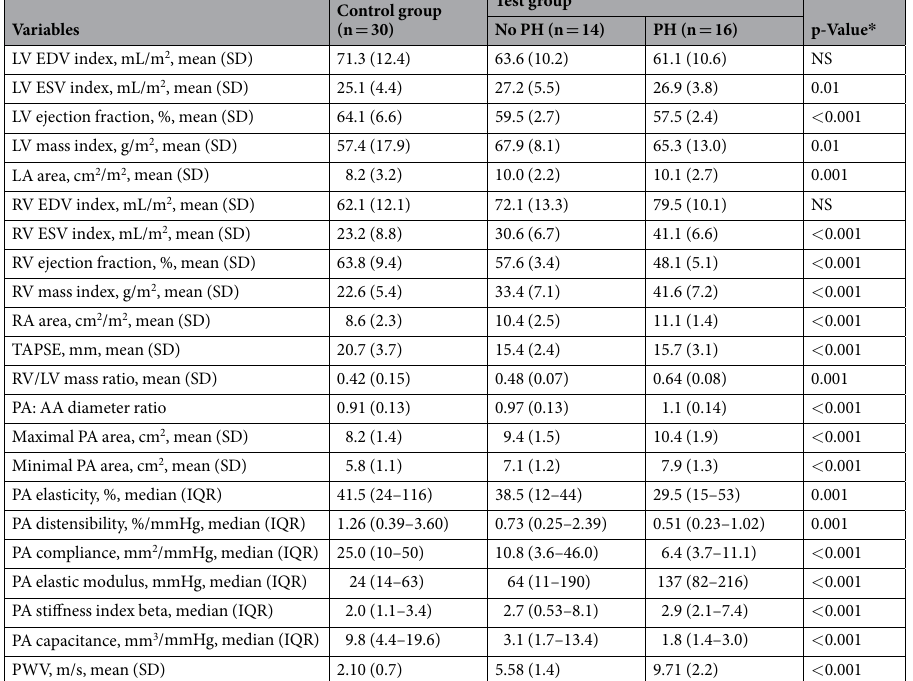
Table 2. CMR imaging characteristics in the study population. Abbreviations: AA, ascending aorta; LA, left atrium; LV, left ventricle; LVEDV, left ventricular end-diastolic volume; LVESV, left ventricular end-systolic volume; PH, pulmonary hypertension; RA, right atrium; RV, right ventricle; RVEDV, right ventricular end- diastolic volume; RVESV, right ventricular end-systolic volume TAPSE, tricuspid annular plane systolic excursion; PA, pulmonary artery; PWV, pulse wave velocity; IQR, interquartile range; SD, standard deviation. * Represents statistical significance between